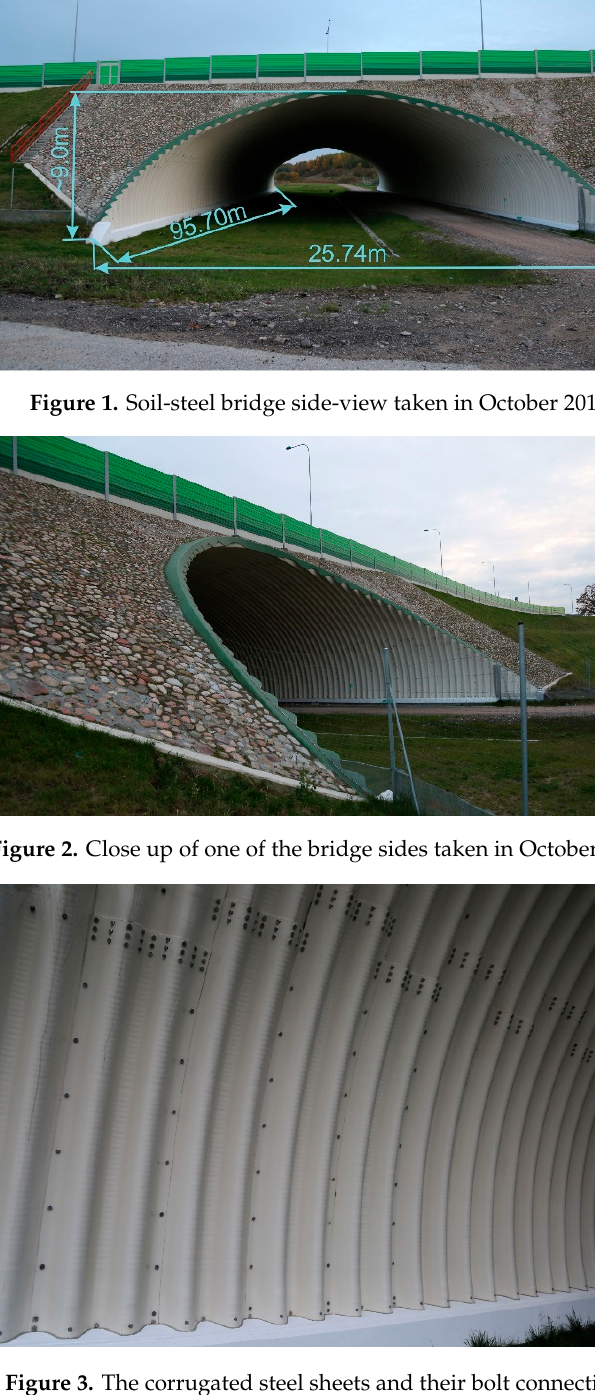
Figure 3. The corrugated steel sheets and their bolt connections.